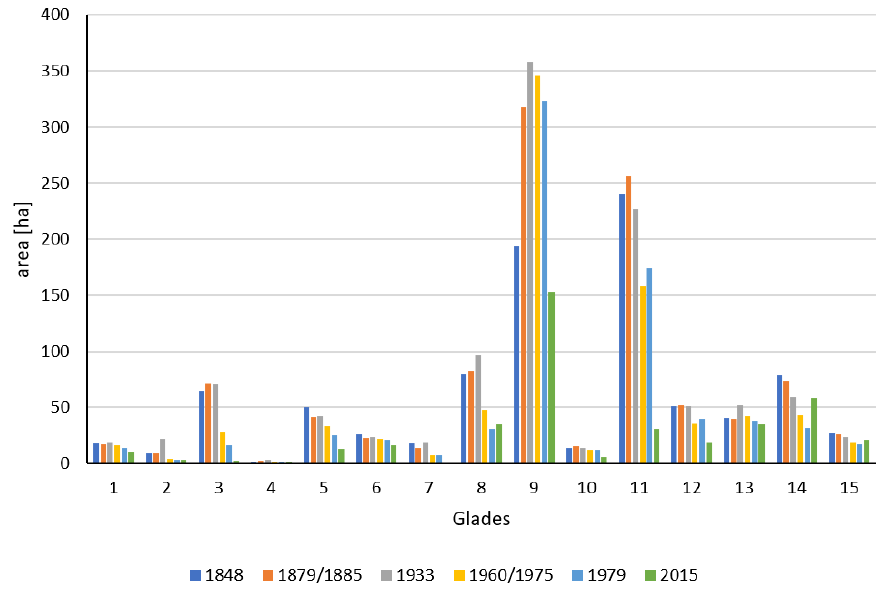
Figure 4. Changes in area of selected glades in the period 1848 – 2015. 1 – 15 — numbers of glades — see Table 1. Table Table 1.